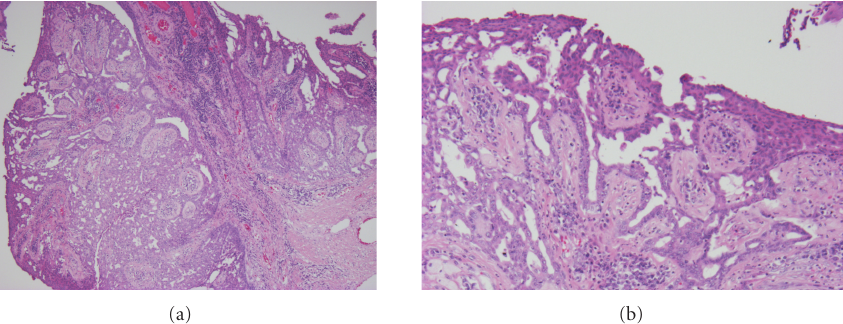
Figure 7: The nodule appeared after chemoradiation therapy showed papilliform structure with invaginate to the dermis and the wall was consisted with two layers of epithelial cells. The outer layer of the epithelium was composed of cuboidal cells and the inner layer of columnar cells. Many plasma cells infiltrated to the interstitial